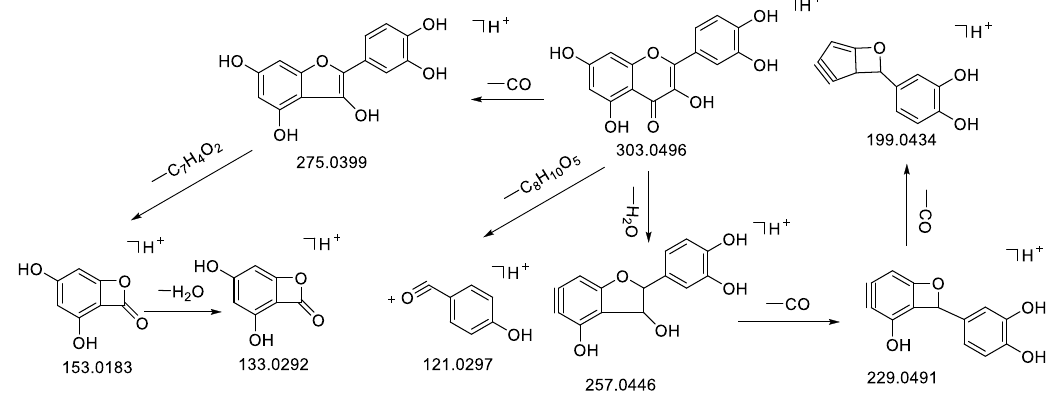
Figure 4. Fragmentation pathway of quercetin in positive ion mode.